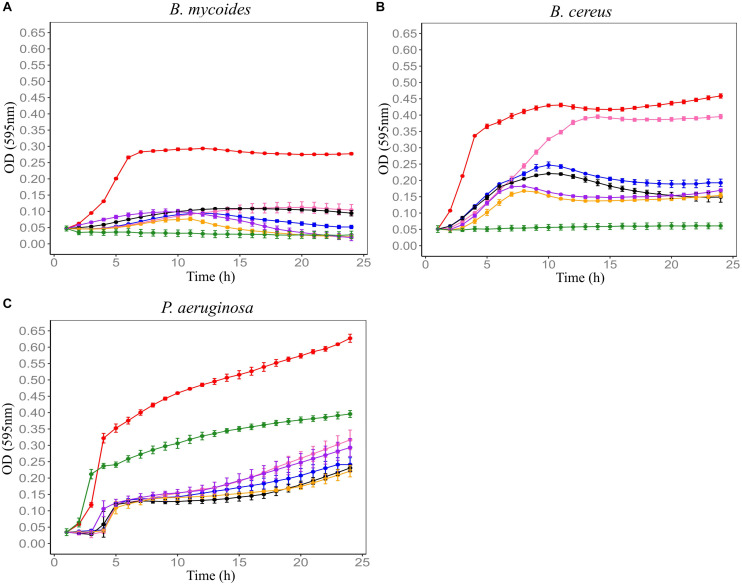
Effect of five soil conditioned media on the growth of B. mycoides ATCC 6462 (A), B. cereus NZRM 5 (B), and P. aeruginosa ATCC 25668 (C). Bacteria were grown in the presence of butterfield’s diluent (red), F1SCM (Farm 1 soil conditioned media; blue), F2SCM (Farm 2 soil conditioned media; pink), F3SCM (Farm 3 soil conditioned media; black), F4SCM (Farm 4 soil conditioned media; orange), F5SCM (Farm 5 soil conditioned media; purple), and nisin (green) in the growth media (CMGS). Nisin (45 μM) and butterfield’s diluent served as positive and untreated control, respectively. Each curve represents the mean growth ± SD (n = 3). All treatments were significantly different from untreated control (p < 0.05).